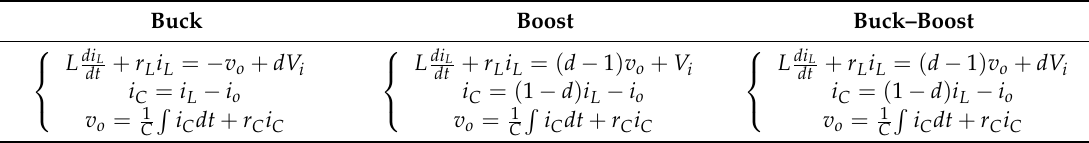
Table 1. Equations for main circuit of DC/DC